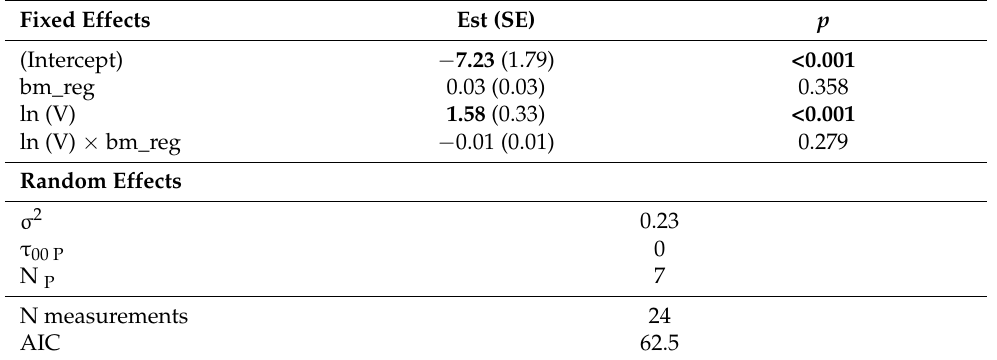
Table 7. Results of the model on periodic annual increment of the main stand as a function of the standing volume (V) and the regeneration biomass (bm_reg) (Equation (6)); Est—estimated value; SE—standard error; p — p -value; significant values are written in bold.